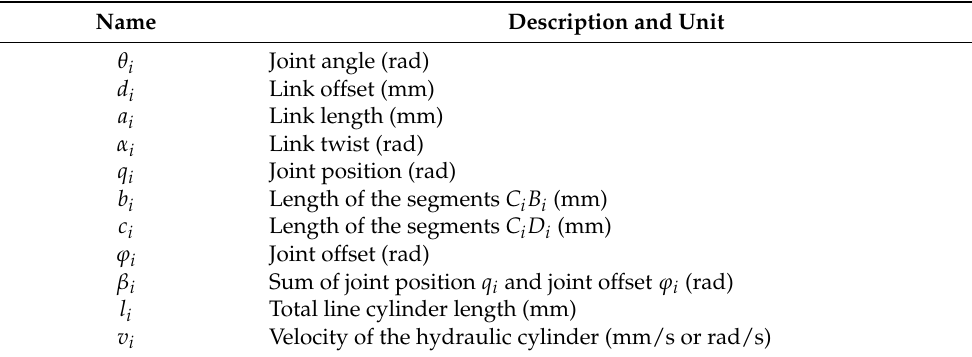
Table A1. Main parameter used in this